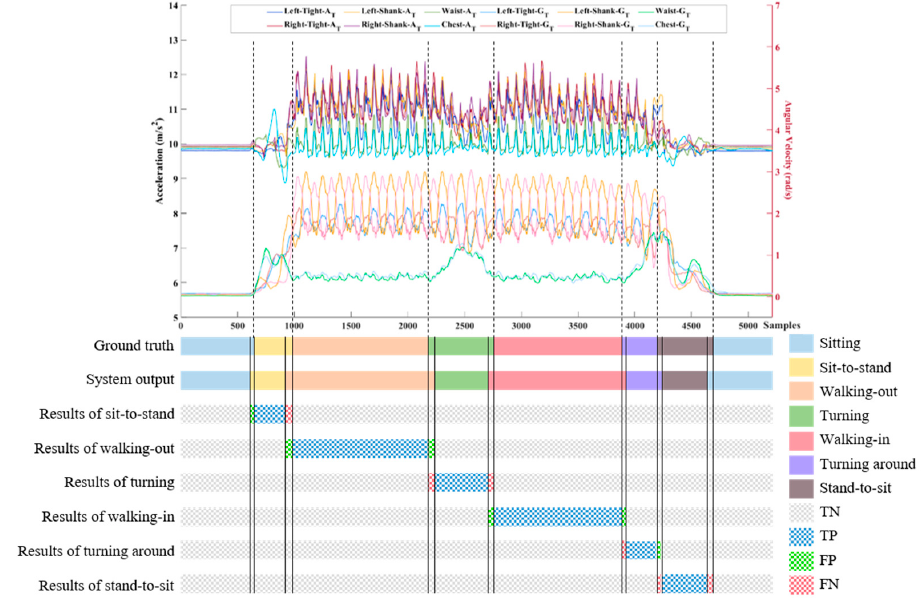
Figure 8. An example of the 10-m TUG test in subtask identification. Only the triaxial acceleration and angular velocity of the waist are plotted in the example. The system output is compared against to the ground truth in terms of true negative (TN), true positive (TP), false positive (FP), and false negative (FN).